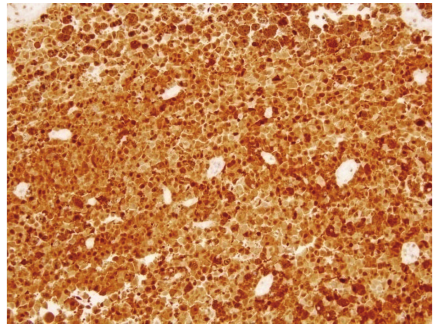
Figure 3: S100 staining, × 200, cells diffusely positive for